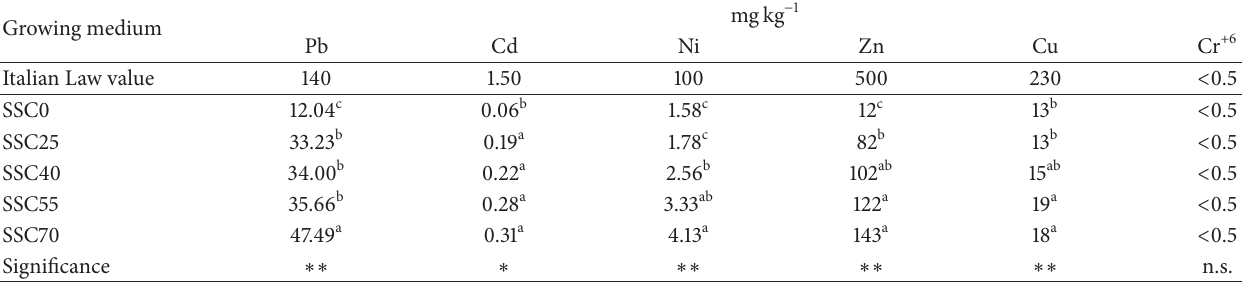
Table 6: Average values of the heavy metals content of the growing media used (at